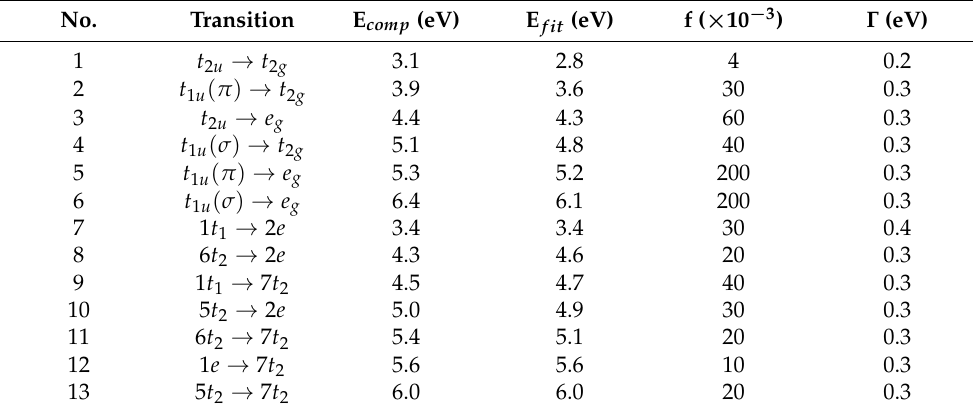
Table 1. Parameters (energies, oscillator strength, line width) of the dipole allowed intra-center CT transitions in octahedral ( 6 A 1 g → 6 T 1 u , number = 1–6) and tetrahedral ( 6 A 1 g → 6 T 2 , number = 7–13) clusters in Y 3 Fe 5 O 12 . E comp and E fit are the computed and fitted CT transition energies, respectively. Adapted from references